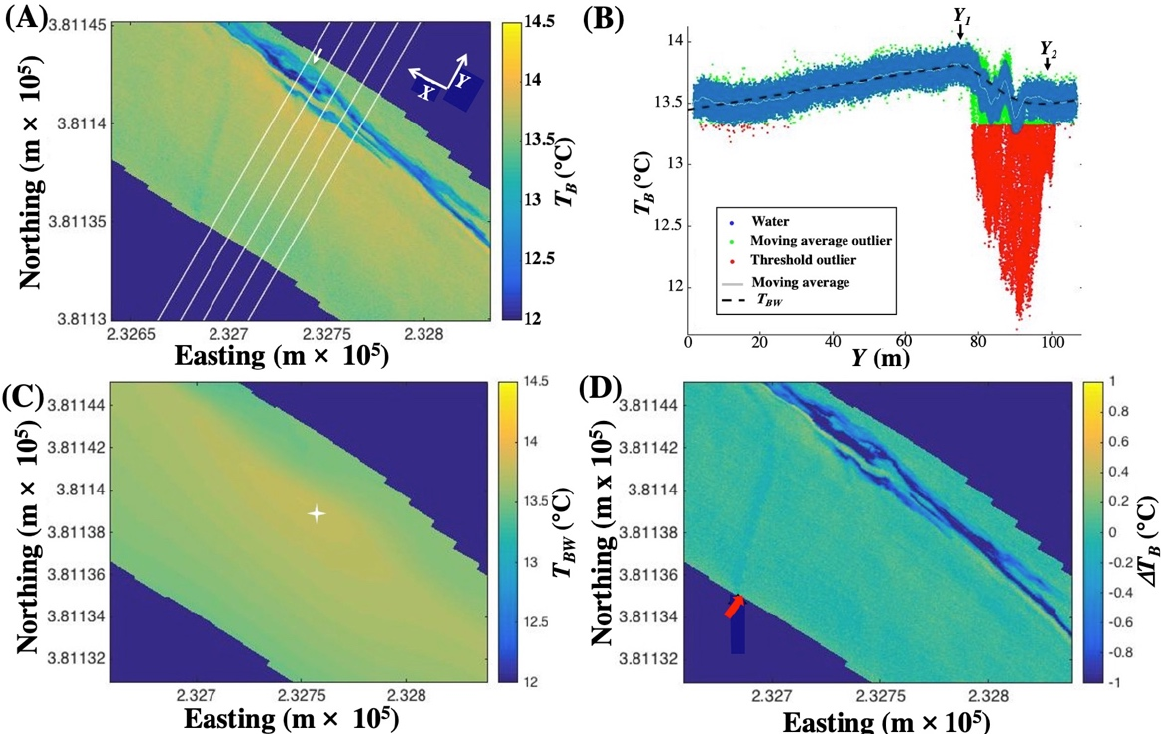
Figure 7. ( A ) Sea surface brightness temperature, T B , mosaic. White arrow locates image for profile in Panel ( B ) and Figure 8. White lines delineate individual mosaic images. Along-slick, X , and cross-slick, Y , coordinates shown. ( B ) T B versus Y for image subset (white arrow Figure 8A), moving average, and model. ( C ) Background water T B and T BW . White star locates warm water pool center. ( D ) Brightness temperature contrast, ∆ T B . Red arrow shows boat wake, data keys on panels. Imagery